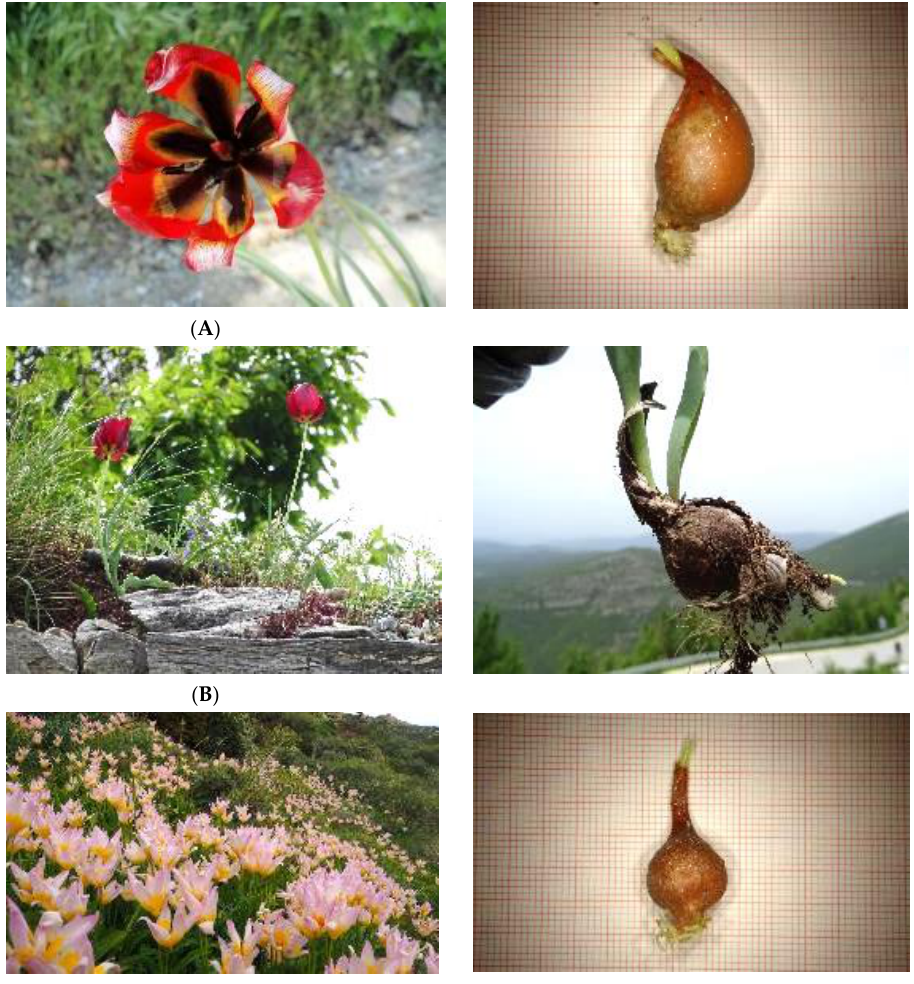
Figure 2. Wild-growing, range-restricted Greek tulips and individual bulbs collected for ex situ conservation in the frame of TULIPS.GR: ( A ) Tulipa bithynica and ( B ) T. rhodopea endemic to southern Balkans and/or Anatolia (Balkan subendemic); ( C ) T. saxatilis (photo: M. Avramakis, Natural History Museum of Crete) endemic to major south Aegean islands (Crete, Karpathos, Rhodes) and south-western Turkey (south Aegean subendemic).